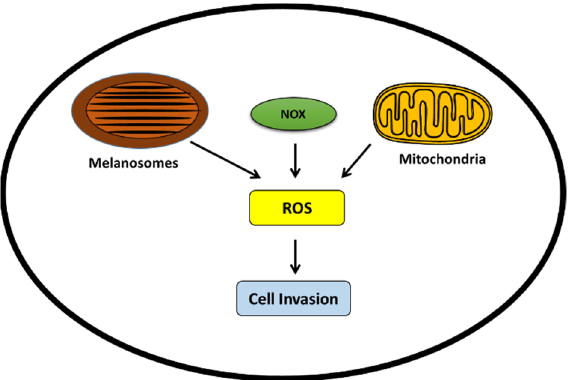
Figure 5. ROS generation in melanoma cells promoting invasive phenotype. ROS can be pro- duced by melanosomes, the NOX family, and mitochondria. High ROS levels can promote the invasive